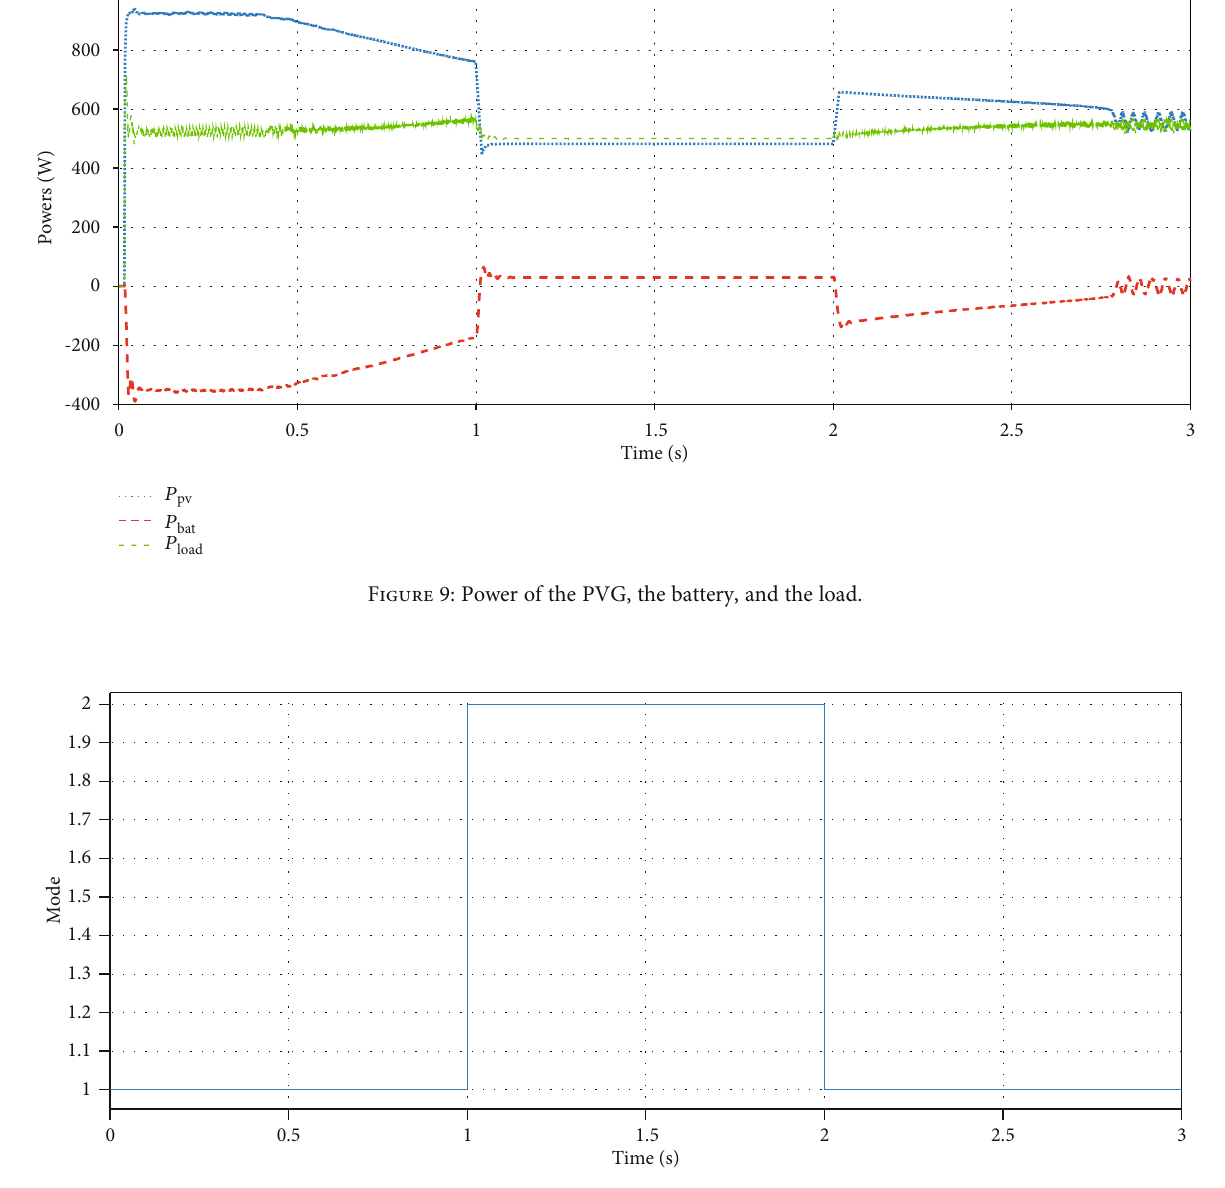
Figure 10: Operation modes.